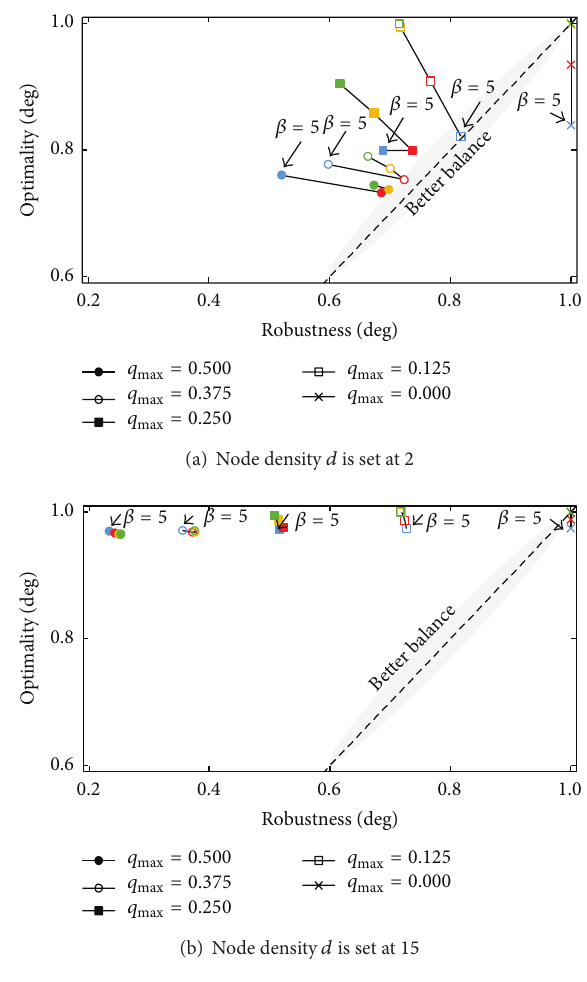
Figure 8: Influence of balance parameter 𝛽 of attractor selection model on balance between robustness and